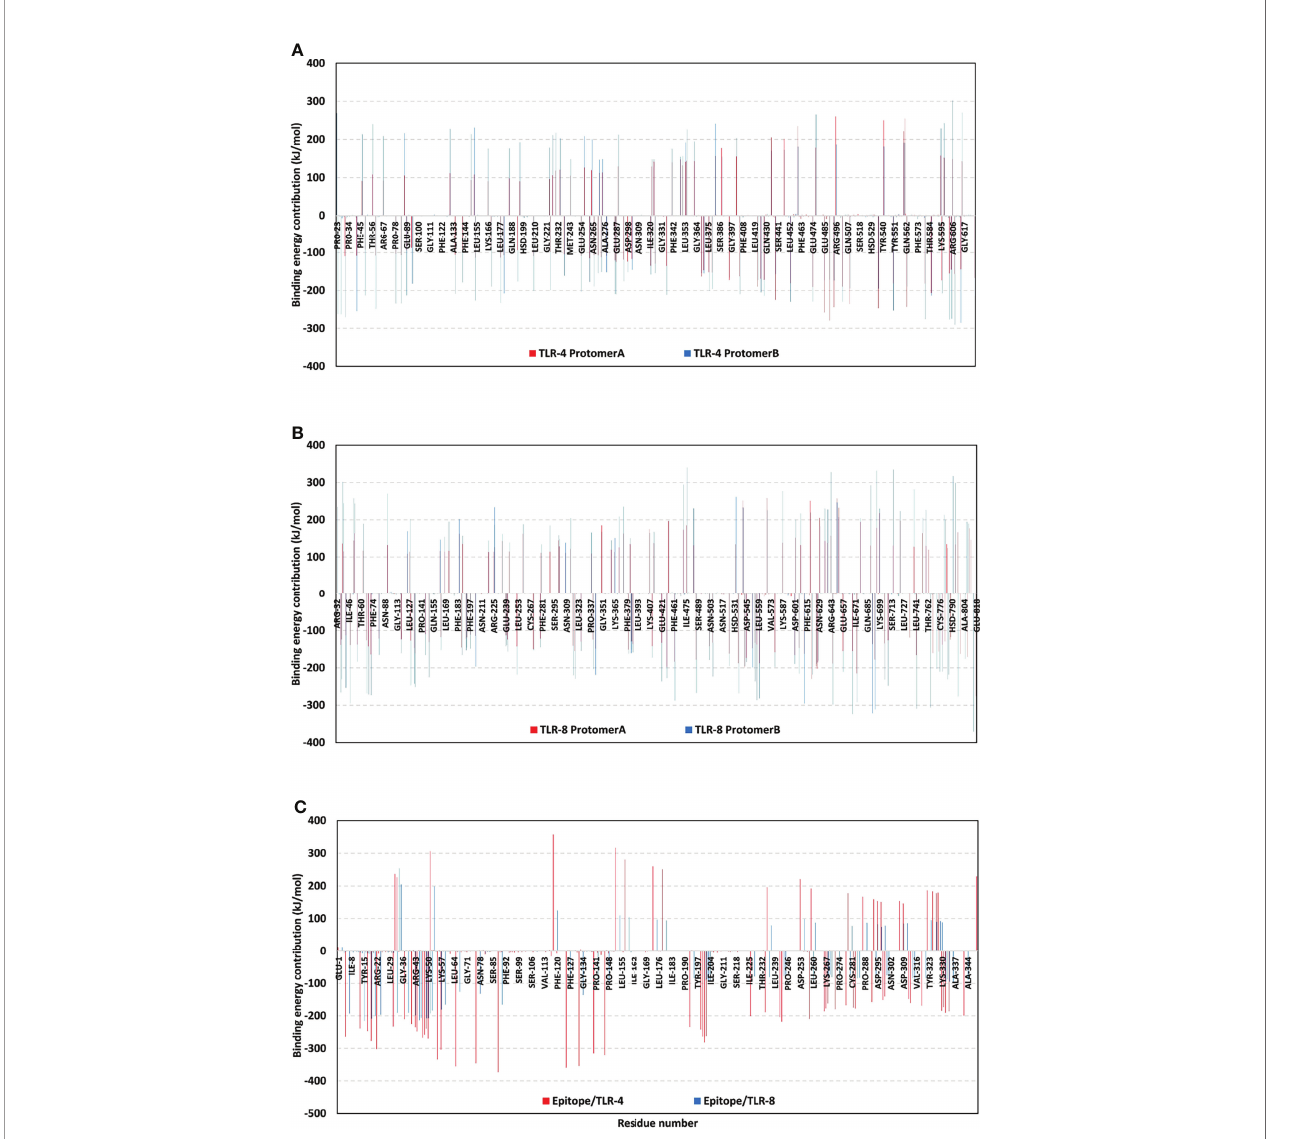
FIGURE 10 | Residue-wise free binding energy contributions for simulated multiepitope vaccine/TLR models. (A) bounded TLR-4 protomers A and B; (B) bounded TLR-8 protomers A and B; (C) bounded multiepitope vaccine at TLR-4 and 8 binding sites. Regions of negative-valued D G kJ/mol confer highly favored binding forces of attraction, while as those of positive-valued D G kJ/mol confer unfavored binding forces of